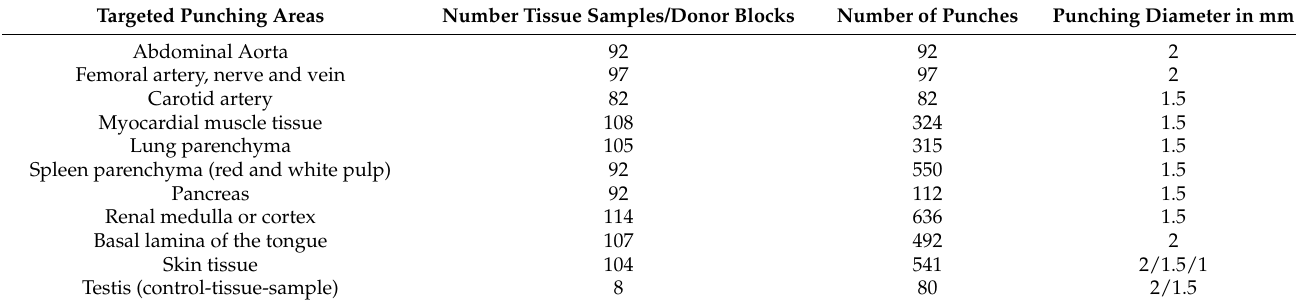
Table 1. Examined tissue types collected from 108 sacrificed Wistar rats. Targeted Punching